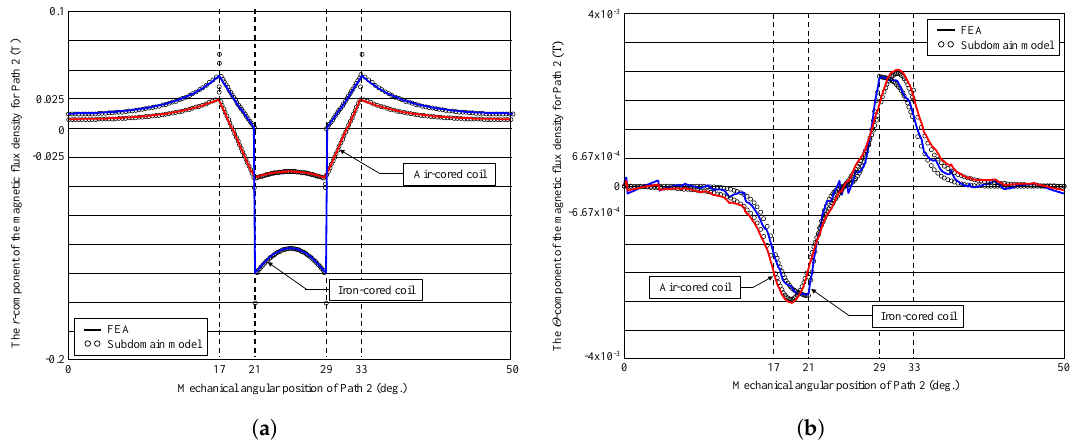
Figure 8. Waveforms of B for Path 2: ( a ) r - and ( b ) Θ -component.